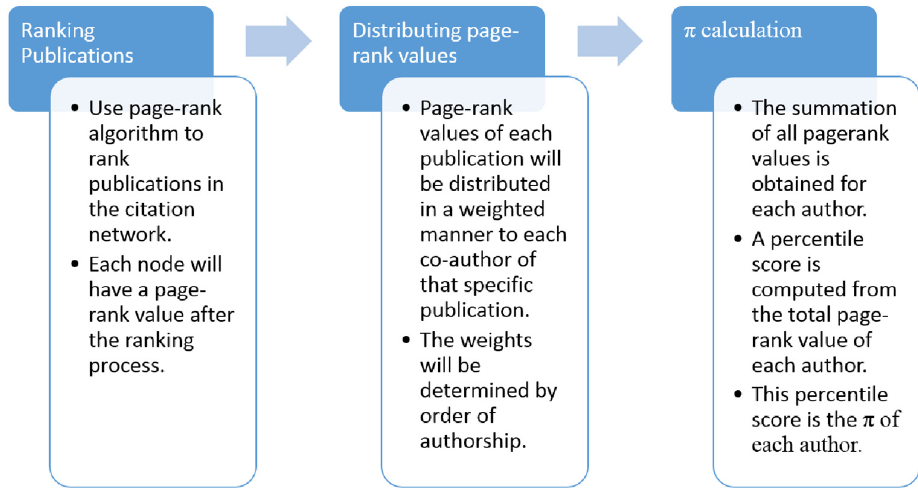
Fig 2. The process of computing pagerank-index. Stage I involves running pagerank algorithm on the citation network and obtaining a pagerank value for each paper. Stage II involves assigning a suitably weighted proportion of each pagerank value to the authors of the corresponding paper. Stage III involves summing all pagerank value ‘ shares ’ an author has obtained, comparing it with other authors in the community and assigning a percentile value to that author accordingly. The considered community could be the world scientific community at large, or a subset thereof.